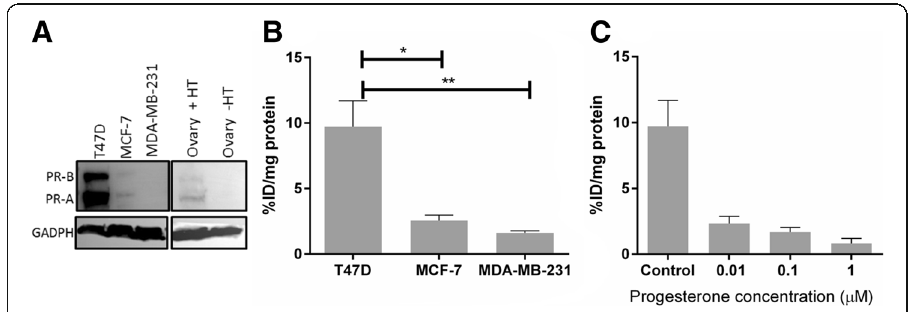
Fig. 3 In vitro characterisation of [ 18 F]2 in breast cancer cell lines with varying PR expression levels. a Western Blot showing PR expression in cell lines and in ovarian of C57BL/6 female mice with or without gonadotropic stimulation of PR expression (+/ − HT). b Uptake of [ 18 F]2 in three cell lines. c Blocking [ 18 F]2 uptake in T47D cells treated with progesterone (0.01 – 1 μ M). Error bars indicate standard errors from n = 3 repeats. Significances are marked with asterisk, (*) and (**) P ≤ 0.05, P ≤ 0.01,